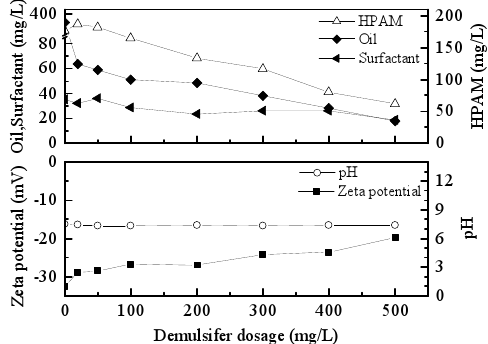
Figure 4. Effect of CP-1 dose on demulsification of EOR PW from the Xinjiang Oilfield. Oil content in PW, 358.5 mg/L. Temperature, 40 °C.